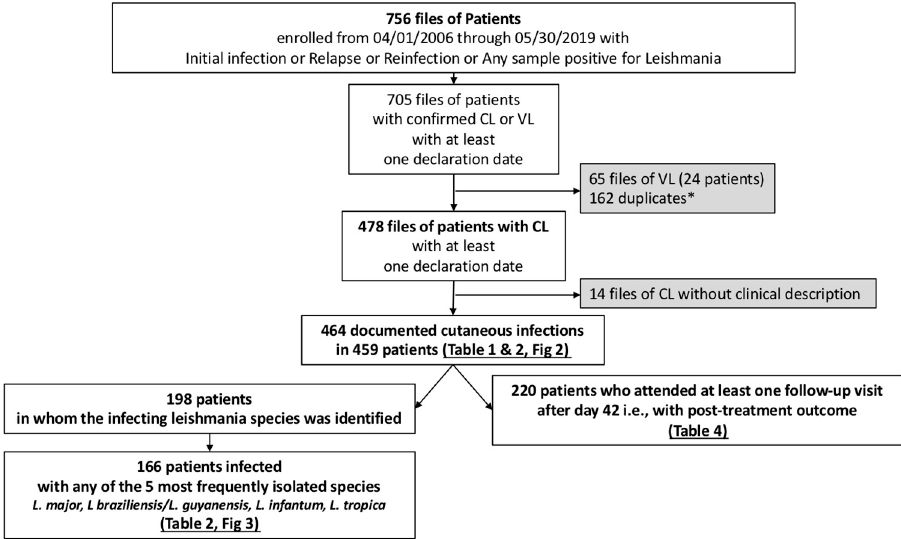
Fig 1. Flow chart of entries in the LeishMan database and selected analyses. Infection, Relapse or Reinfection correspond to a documented episode of visceral or cutaneous leishmaniasis, with or without mucosal involvement. � patients with multiple follow-up visits or samples. Notes: A “Patient” file corresponds to demographic information. A “Sample” file corresponds to one sample collected in one site with one technique at one date (eg. PCR on skin biopsy of right hand collected the 25 th of May 2017). Abbreviations: CL, cutaneous leishmaniasis; VL, visceral leishmaniasis